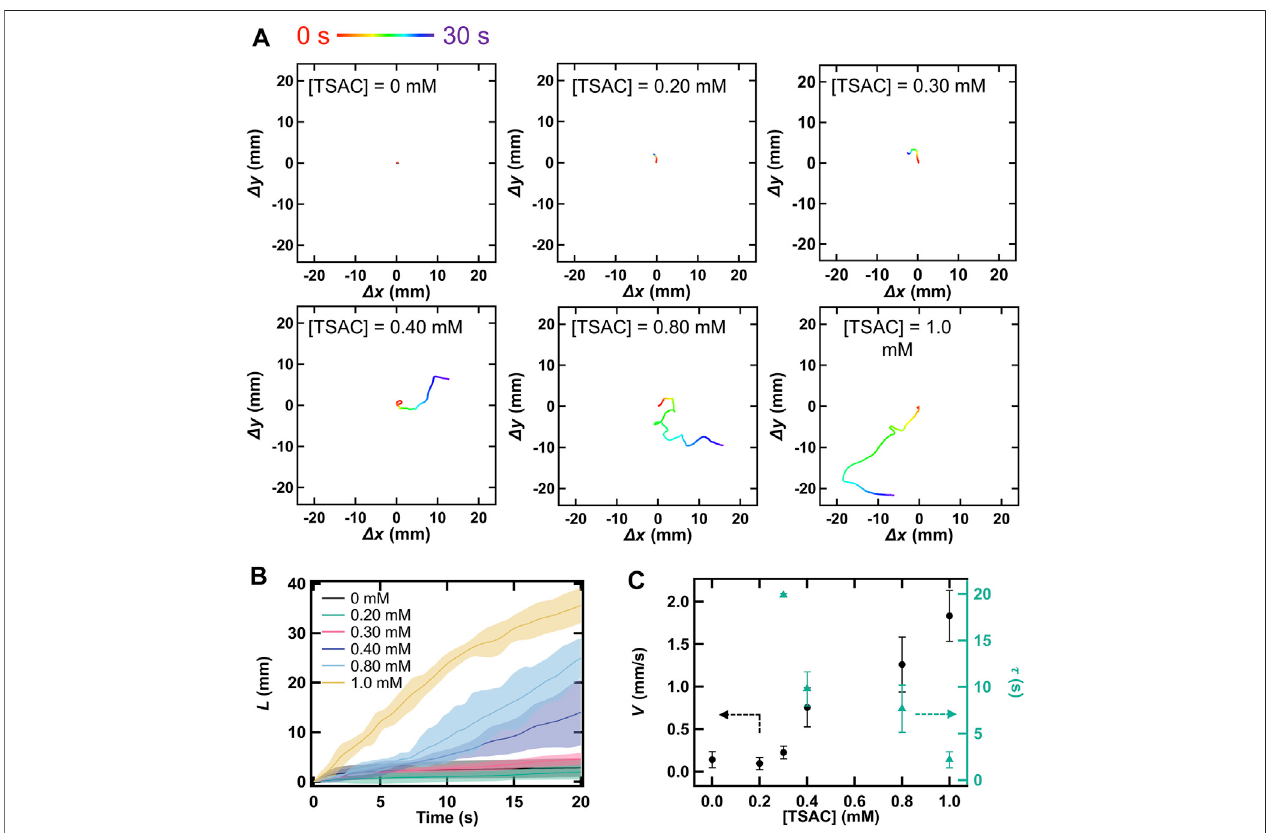
FIGURE2|(A) Locomotionofadroplet over 20 sowingtoits self-propelledmotionat differentTSAC concentrationsintherangeof0 – 1.0 mM([DMPC] =2.0 mg/ ml and [I 2 ] = 10 mM). Quantity of motion with respect to the x- or y- direction is calculated as a displacement value with respect to an initial pipetted position. (B) Relationship between time and the total path length of droplet movement during 20 s ( L ) at different TSAC concentrations, where t = 0 represents the time of pipetting. (C) Variation in the mean motion speed of the droplet ( V ) and induction period ( τ ) at different TSAC